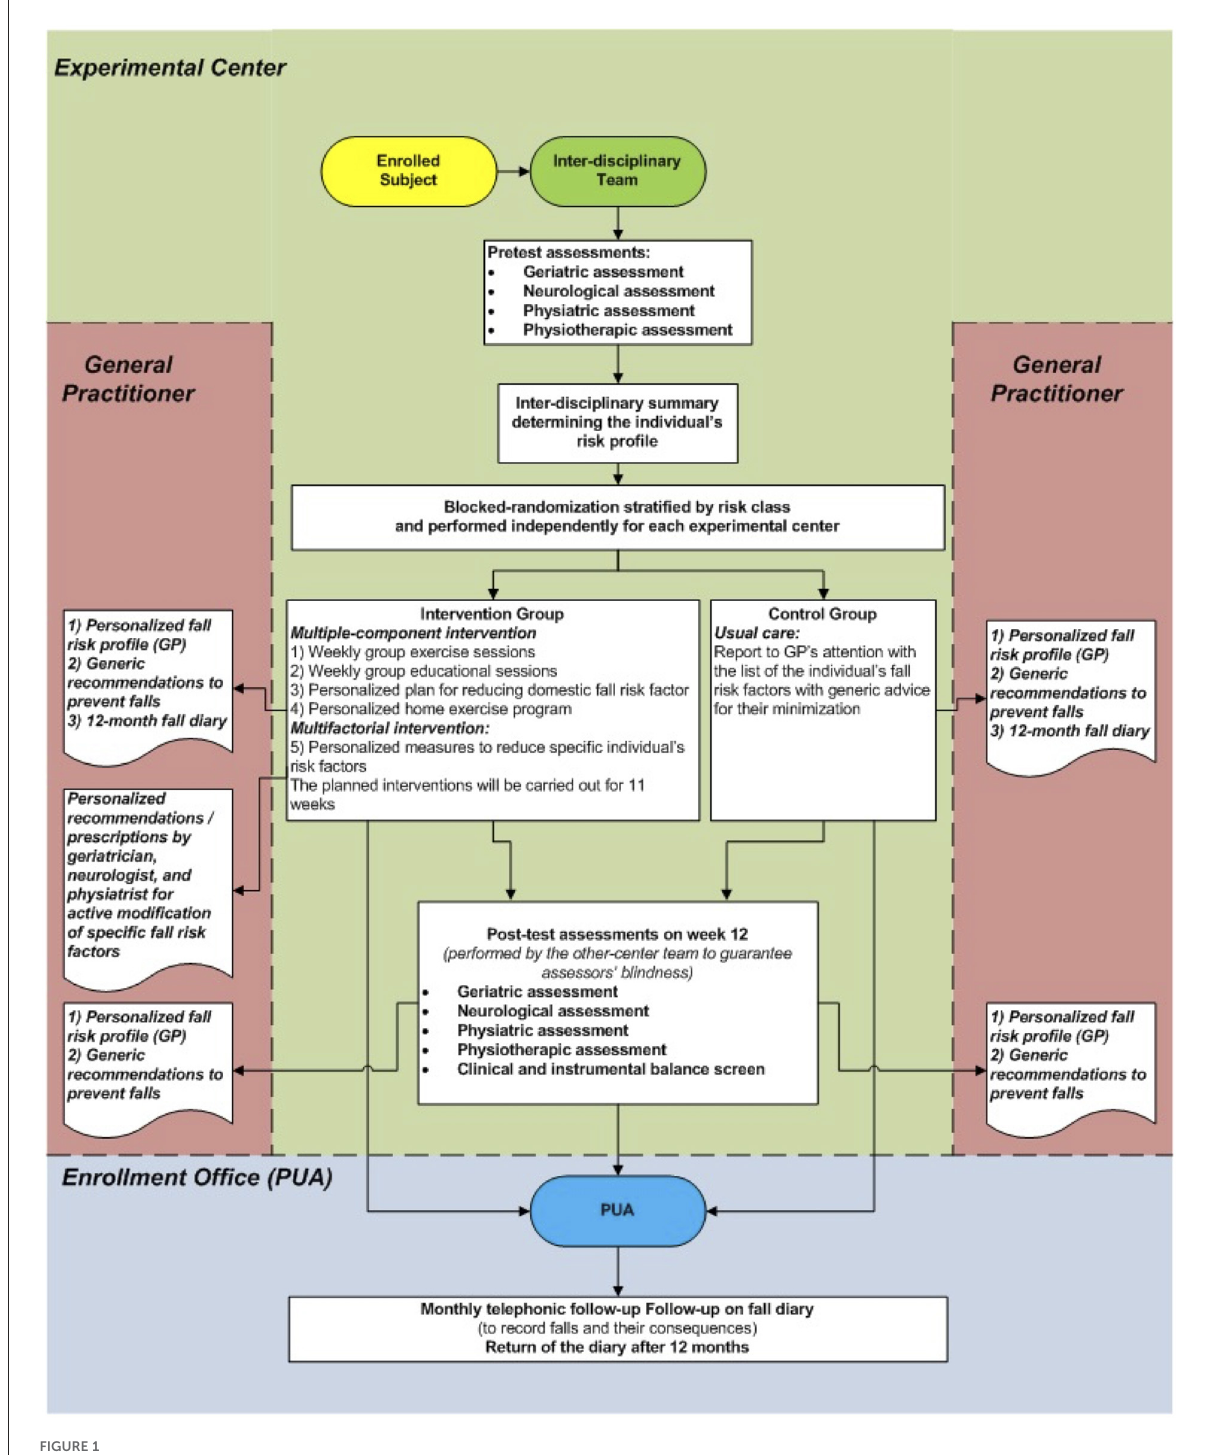
FIGURE1 Study summary flow